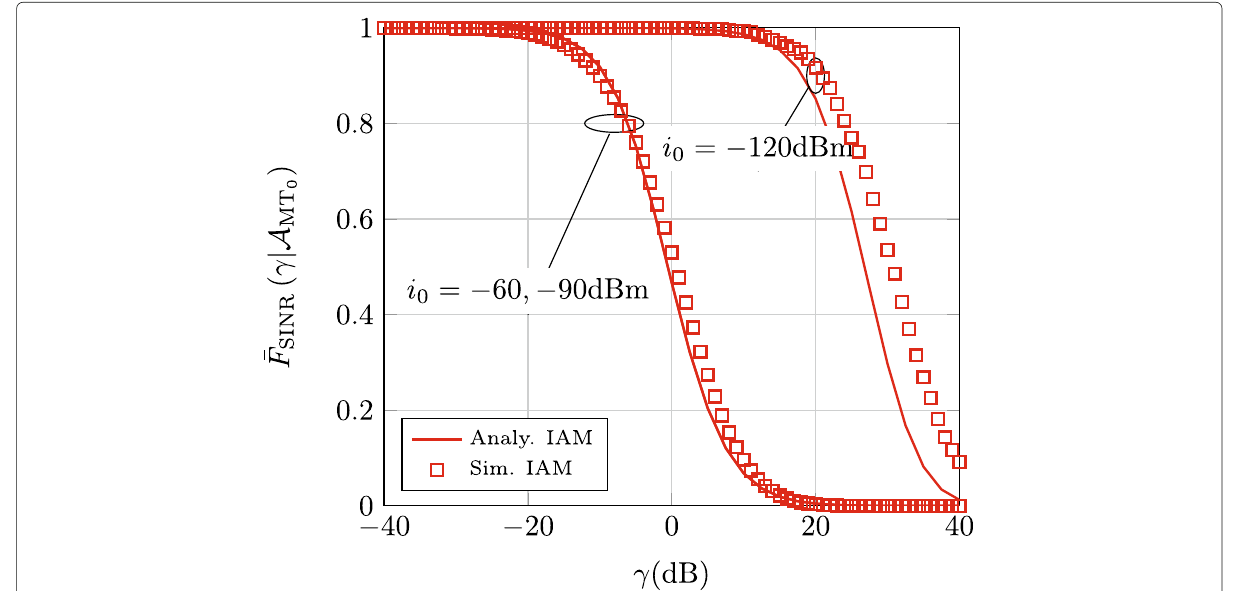
Fig. 6 CCDF of the SINR for the typical MT conditioned on being active for IAM with (cid:5) = 0.75, t ( 1 ) / t ( 2 ) = 9 dB, p max → ∞ and i 0 = {− 120, − 90, − 60 }